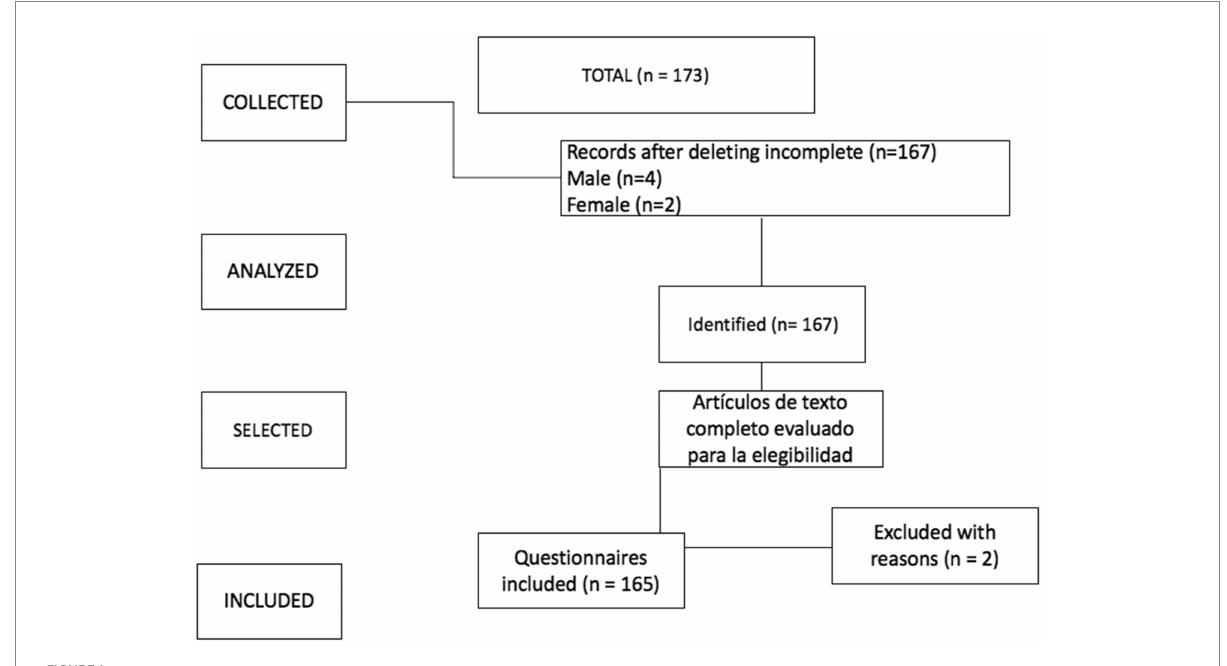
FIGURE 1 Flowchart of the selection procedure.